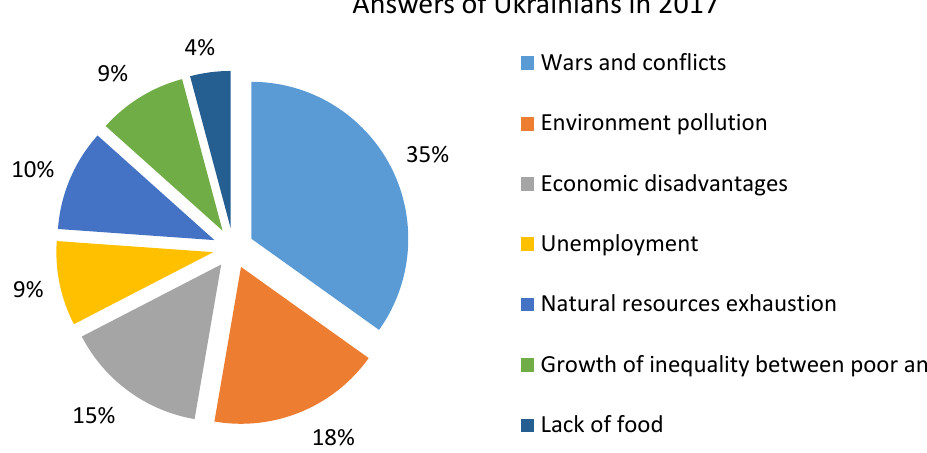
Figure 2. Detection of global threats for future generations: answers of Ukrainians in 2017